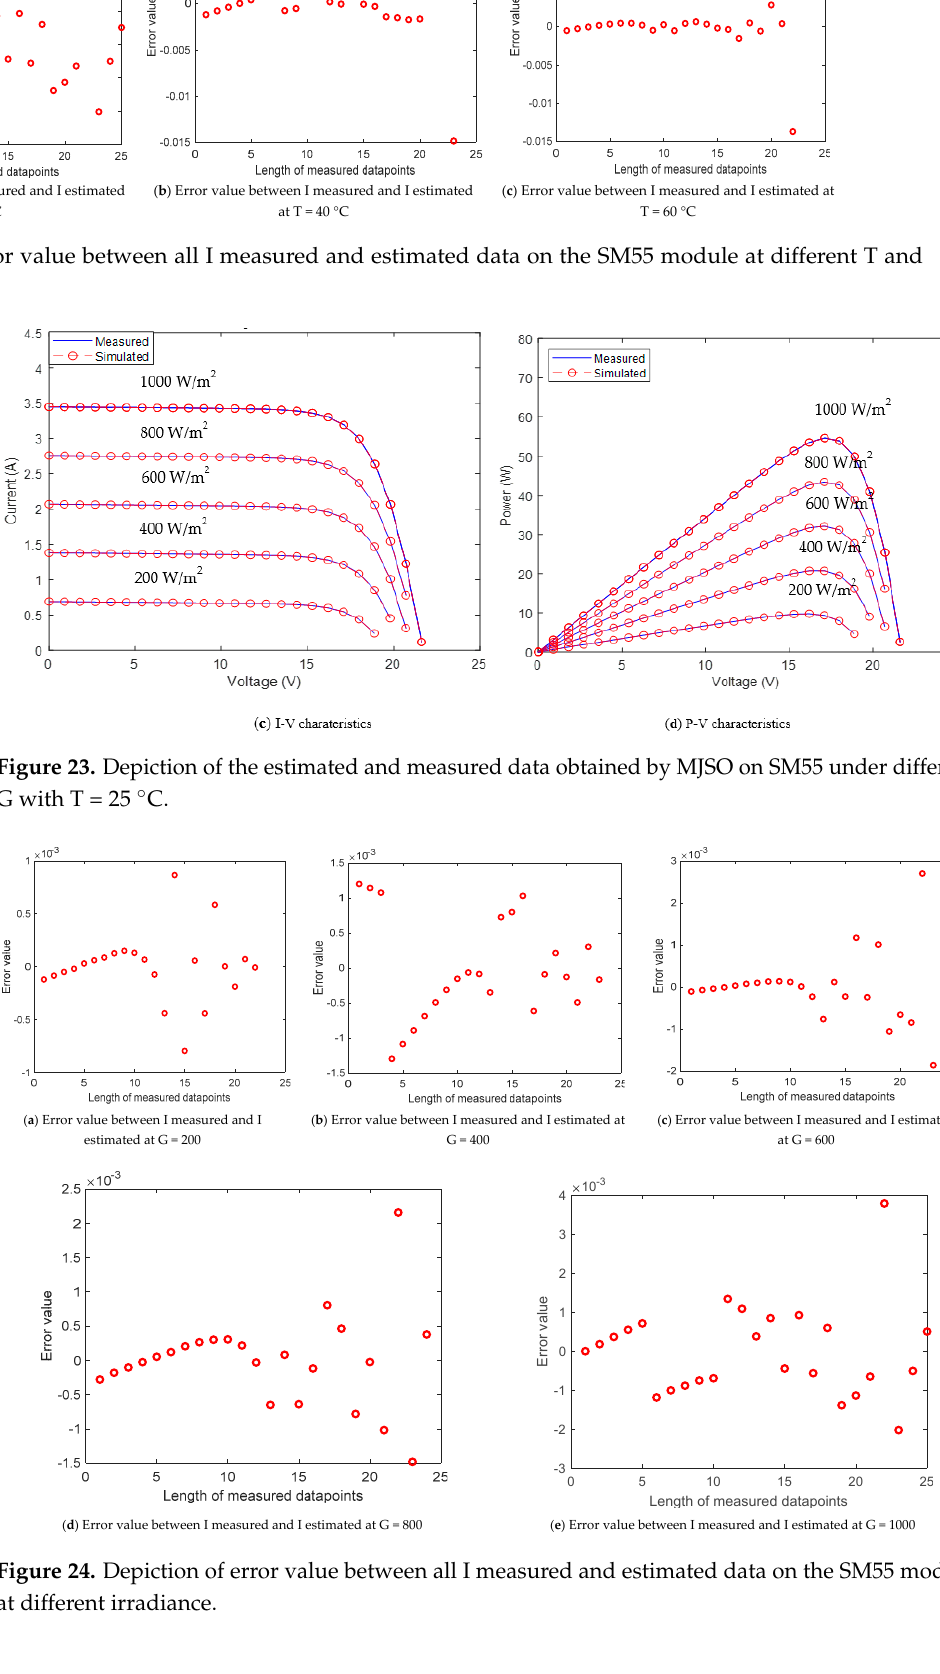
( a ) I–V characteristics ( b ) P–V characteristics Figure 25. Depiction of the measured and simulated data obtained by MJSO on ST40 under different G with T = 25 °C.